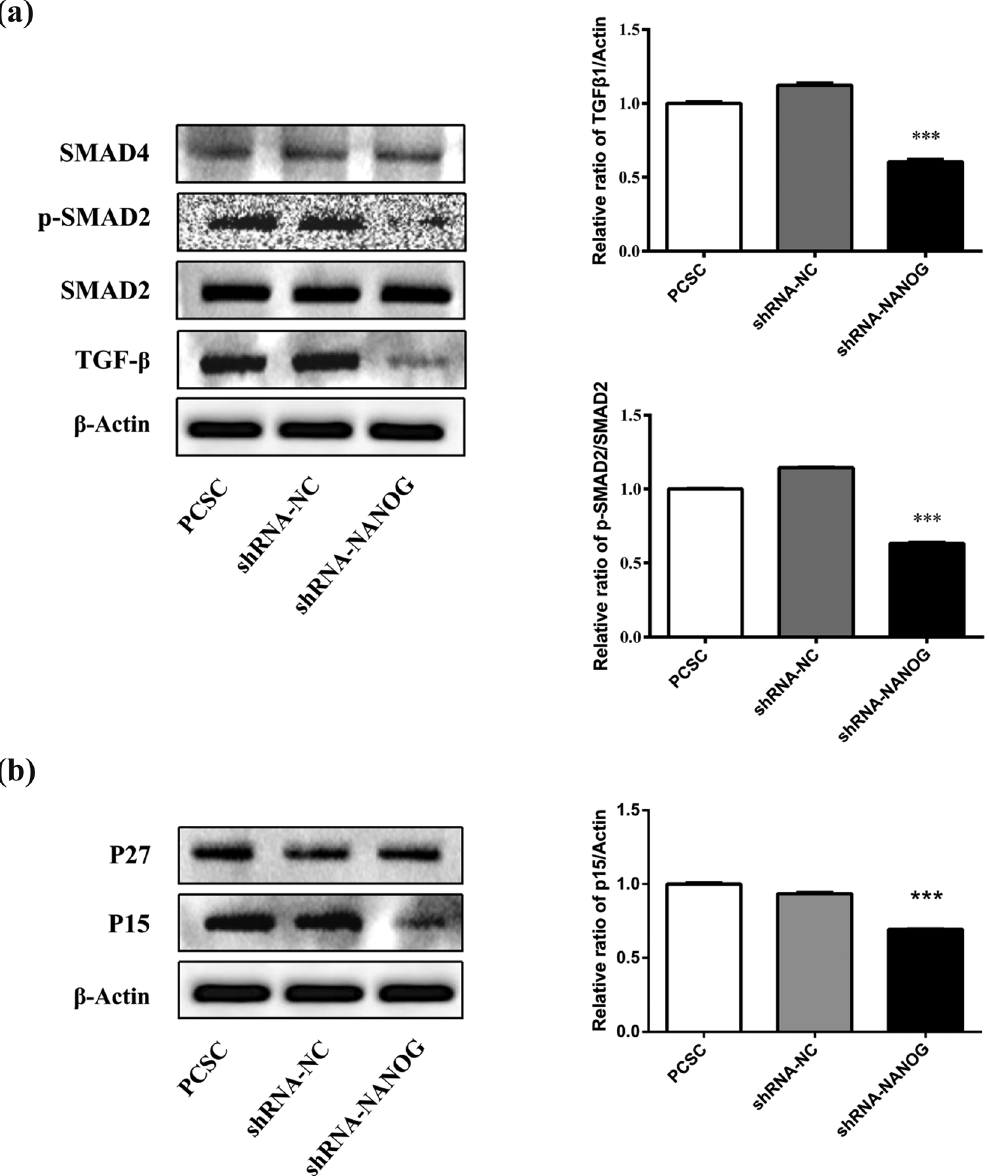
Figure 4: shRNA - NANOG regulates the TGF - β 1/SMAD signaling pathway. The protein levels of TGF - β 1, SMAD2, p - SMAD2, SMAD4, p27, and p15 were detected using Western blot analysis. The inhibition of NANOG signi fi cantly downregulated the protein expressions of TGF β 1, p15, and p - SMAD2 ( * p < 0.05, ** p < 0.01, and *** p < 0.001 ) , while it had little e ff ect on p27, SMAD4, and